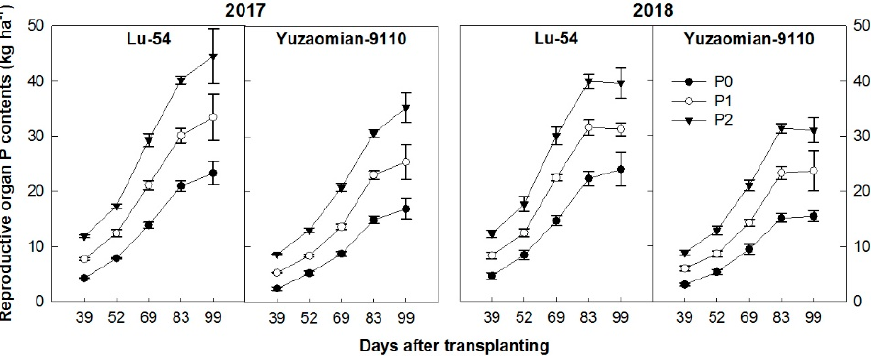
Figure 4. The accumulation of total P contents (kg ha − 1 ) in reproductive organ of cotton plant for Lu-54 and Yuzaomian-9110 in 2017 and 2018. The treatments P0, P1, and P2 represent the P levels, i.e., 0, 100 and 200 P 2 O 5 kg ha − 1 . The data are the means of three replications ± standard error.